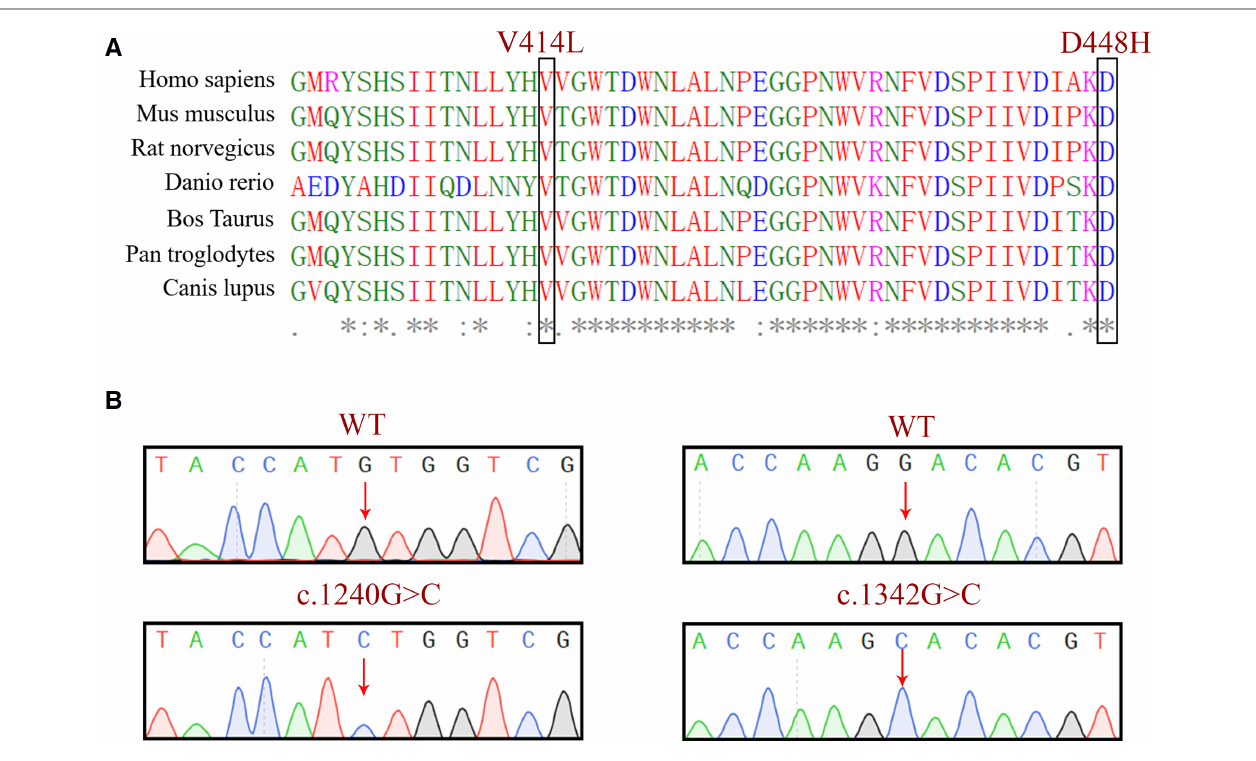
FIGURE 3 ( A ) Evolutionary conservation analysis of a multiple sequence alignment of the GCase. The comparison between different eukaryotic species, showing that the base pair involving the nucleotide at positions 1,240 and 1,342 in GCase are highly conserved. ( B ) Sequencing validation of the constructed